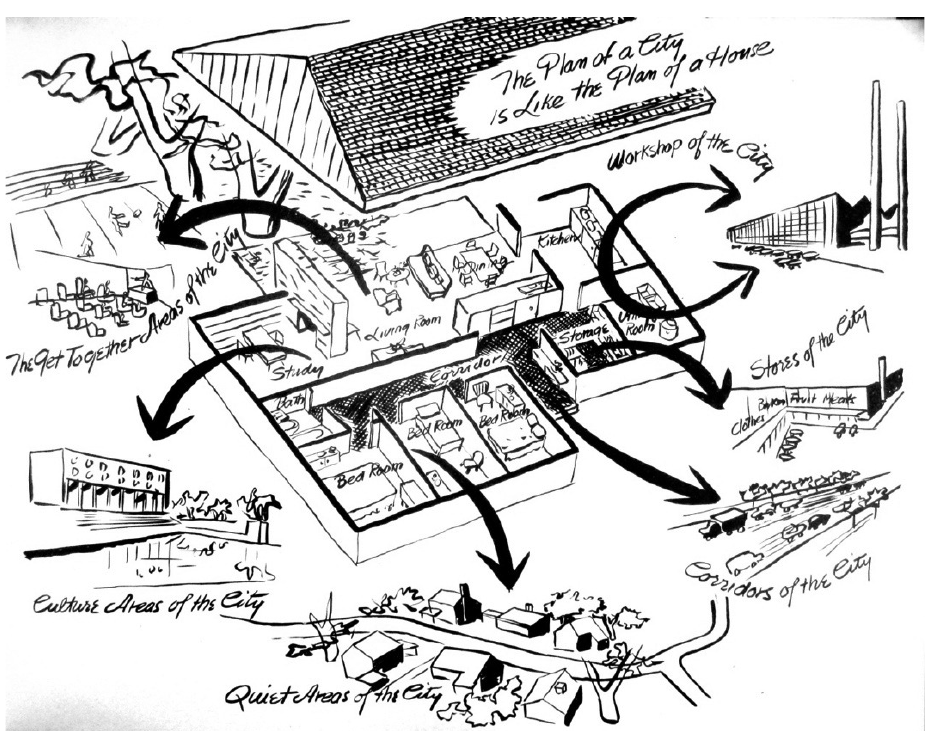
Figure 7. “The plan of the city is like the plan of a house.” Source: Stonorov and Kahn (1944). These attempts intended to create a balanced